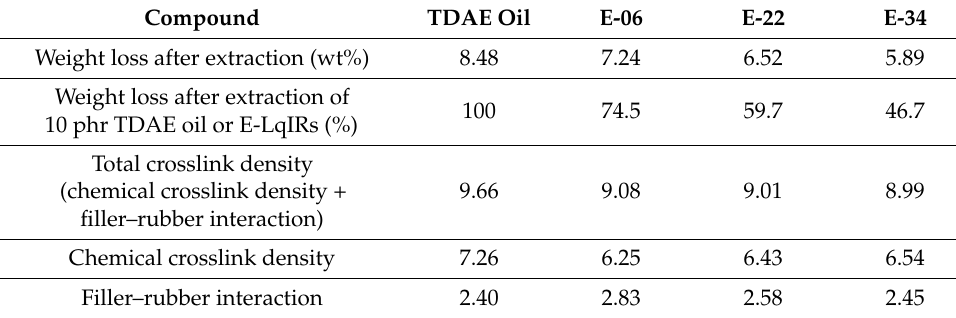
Figure 6. Crosslink densities of the vulcanizates. Table 6. Weight loss and crosslink densities of the vulcanizates (units: 10 − 5 mol/g).